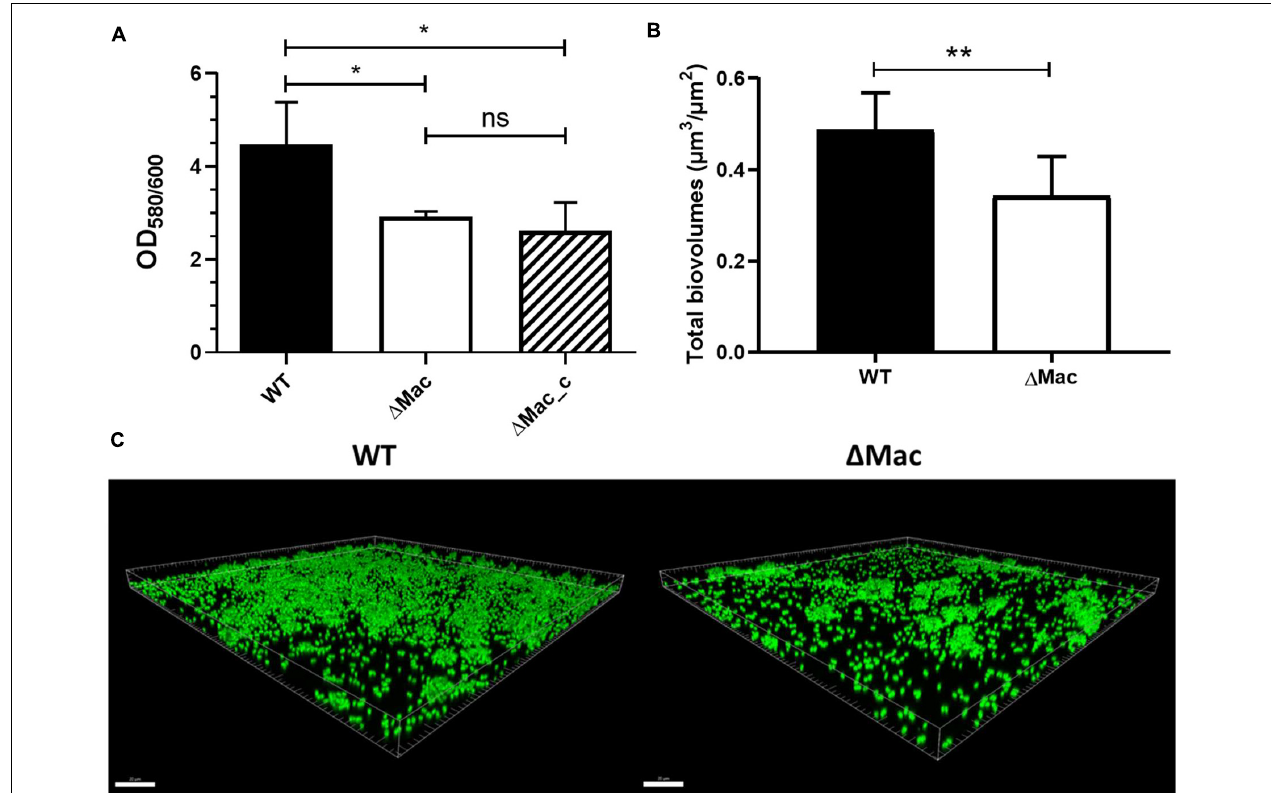
FIGURE 2 | Impact of the macAB-tolC deletion on A. baumannii biofilm formation at the solid–liquid interface. (A) Biomass quantification by crystal violet staining of A. baumannii ATCC 17978 wild type (WT), (cid:49) Mac, and (cid:49) Mac_c ( (cid:49) Mac complemented strain). (B) Quantification of biovolume ( µ m 3 / µ m 2 ) of A. baumannii ATCC 17978 WT and (cid:49) Mac biofilms based on the confocal fluorescence images. (C) Representative confocal laser scanning microscopy (CLSM) images of A. baumannii ATCC 17978 WT (left) and (cid:49) Mac biofilms (right) labeled with Syto9. Data shown represent mean values ( ± SD) from at least three independent biological experiments (ns, not significant; * p < 0.05; ** p < 0.01). Scale bar: 20 µ m. OD, optical